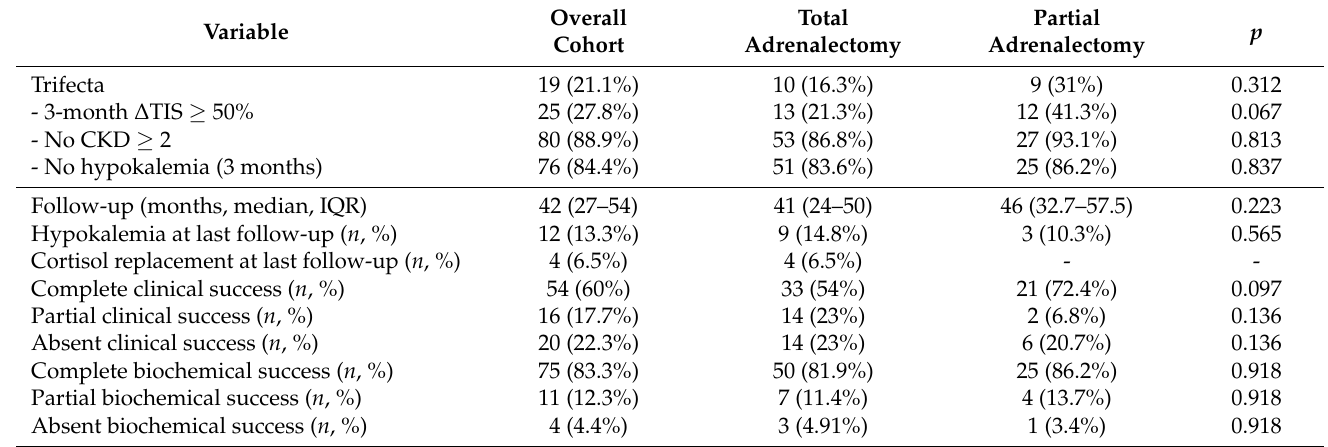
Table 4. Early and long-term functional outcomes after MIPA or